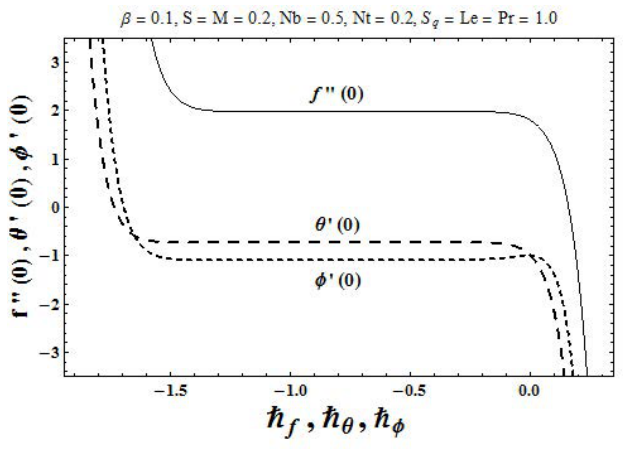
Figure 1. ¯ h -Curves for f , θ and φ at the lower disk.